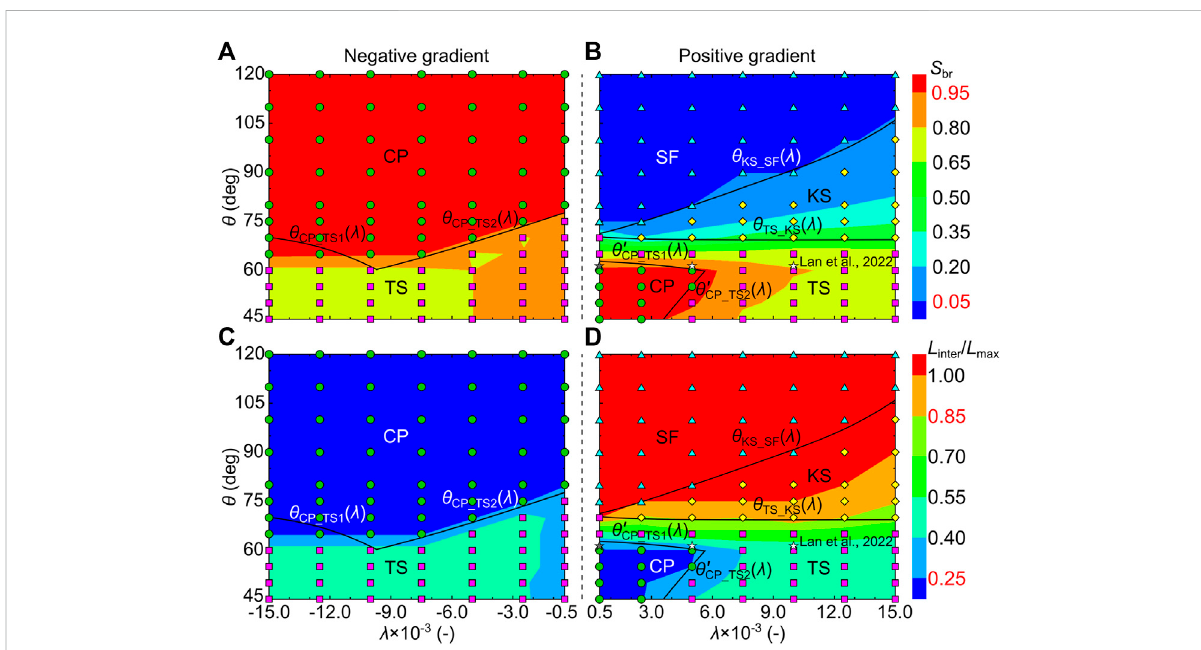
FIGURE 10 Evaluatingthetheoreticalmodelusingnumericalsimulationsinthe λ - θ planeandexperimentsintheliterature[30].Thewettingconditionsvary from 45 ° to 120 ° . The gradients vary from − 1.5 × 10 − 2 to -5 × 10 − 4 for negative gradient porous media and from 5 × 10 − 4 to 1.5 × 10 – 2 for positive gradientporousmedia.Thecontourplotsofbothsaturation S br (A,B) andnormalized fl uid – fl uidinterface L inter / L max (C,D) arepresentedwithredfora higher value and with blue for a lower value. The dots represent the simulated displacement patterns in Figure 9 and Supplementary Figure S4, S5 with green circles for the compact pattern (CP), purple squares for the taper shape pattern (TS), yellow diamonds for the kite shape pattern (KS), and blue triangles for the single fi ngering pattern (SF). (B,D) Stars represent the experimented displacement patterns in the positive gradient porous media [30], with the gray star for the compact pattern (CP) and white stars for the taper shape pattern